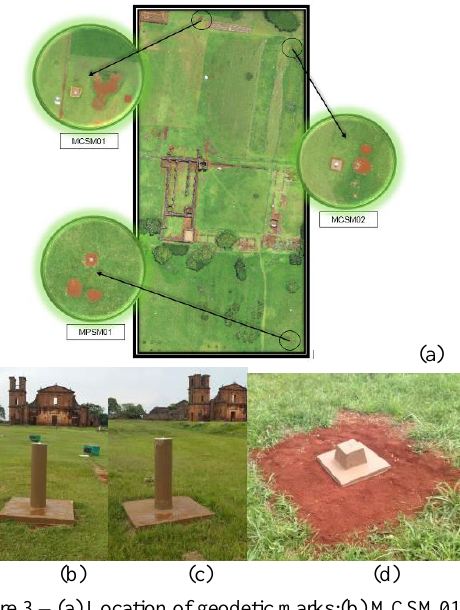
Figure 3 – (a) Location of geodetic marks;(b) MCSM01;